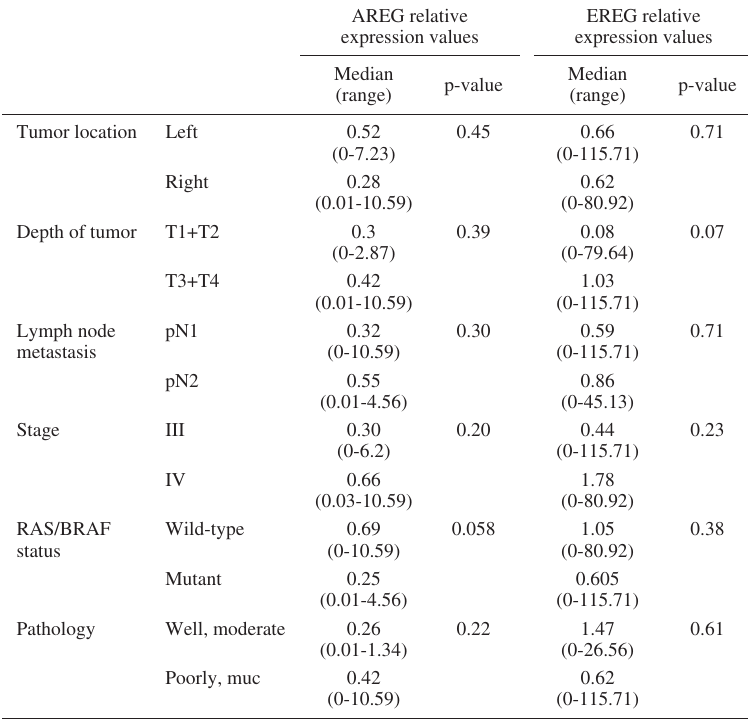
Table 2. AREG and EREG expressions and clinicopathological